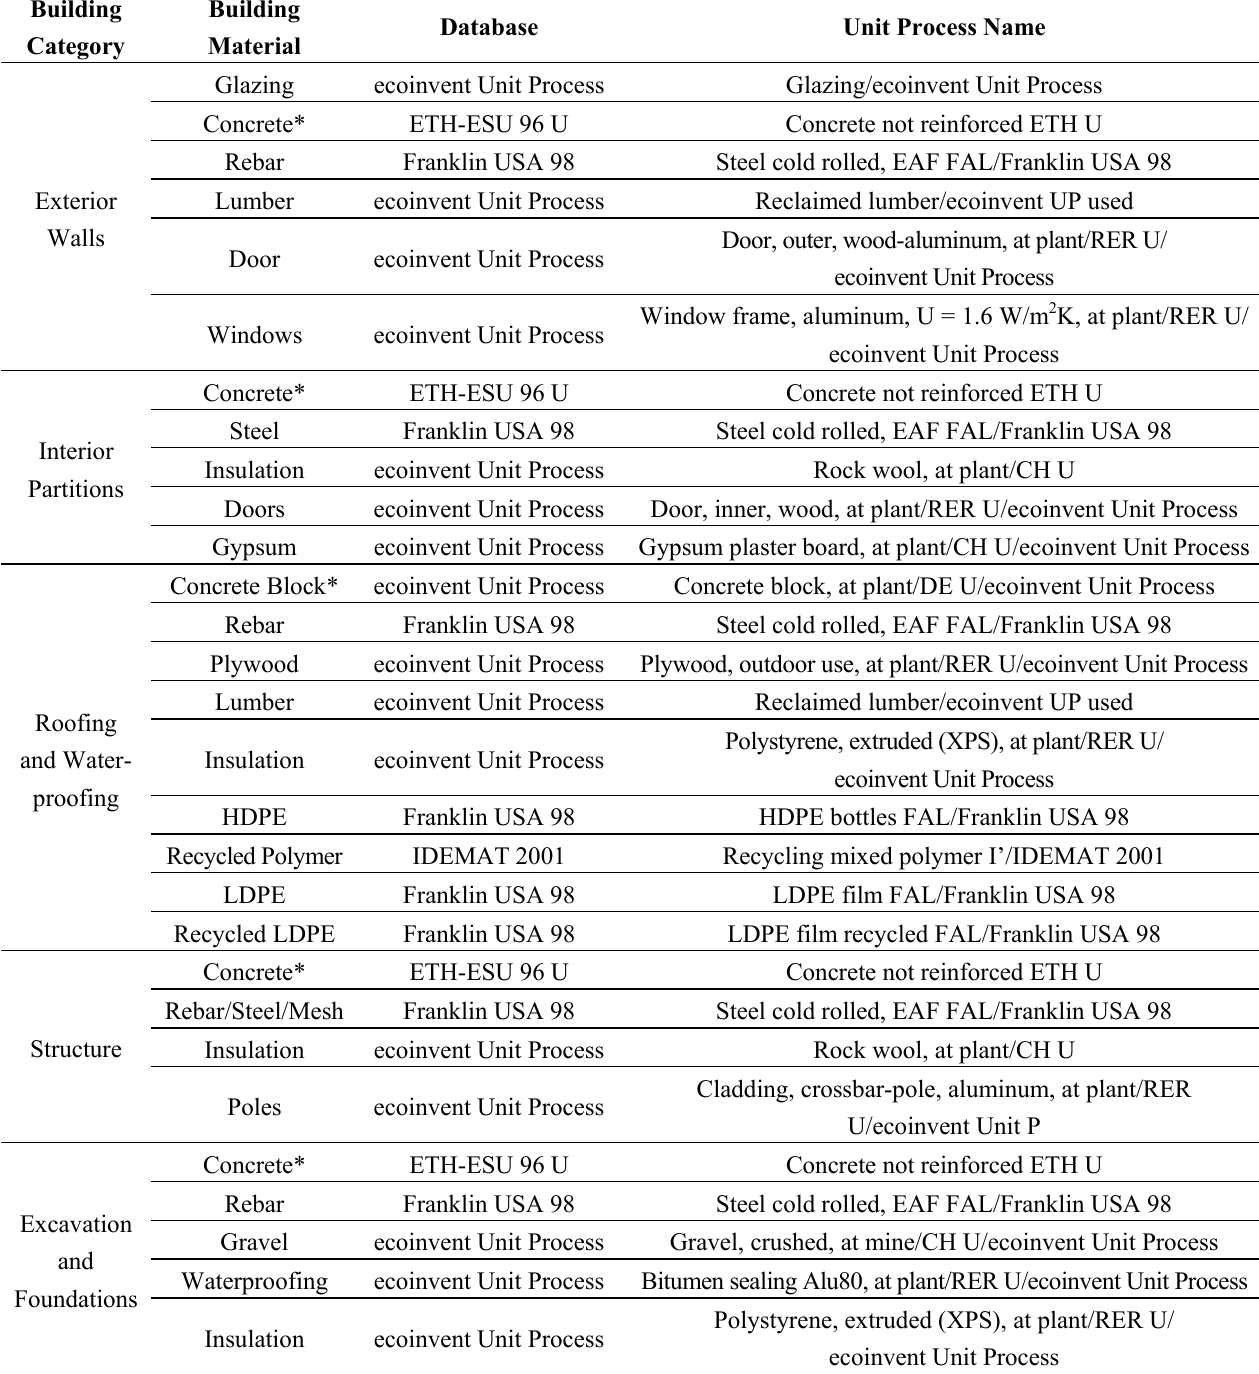
Table 1. LCI Databases for Building Materials. CH = Switzerland geographical code; RER = Europe geographical code; U = unit process; FAL = Franklin Associates code; ecoinvent Unit Process [5]; ETH-ESU 96 U [4]; Franklin USA 98 [34]; Industry Data 2.0